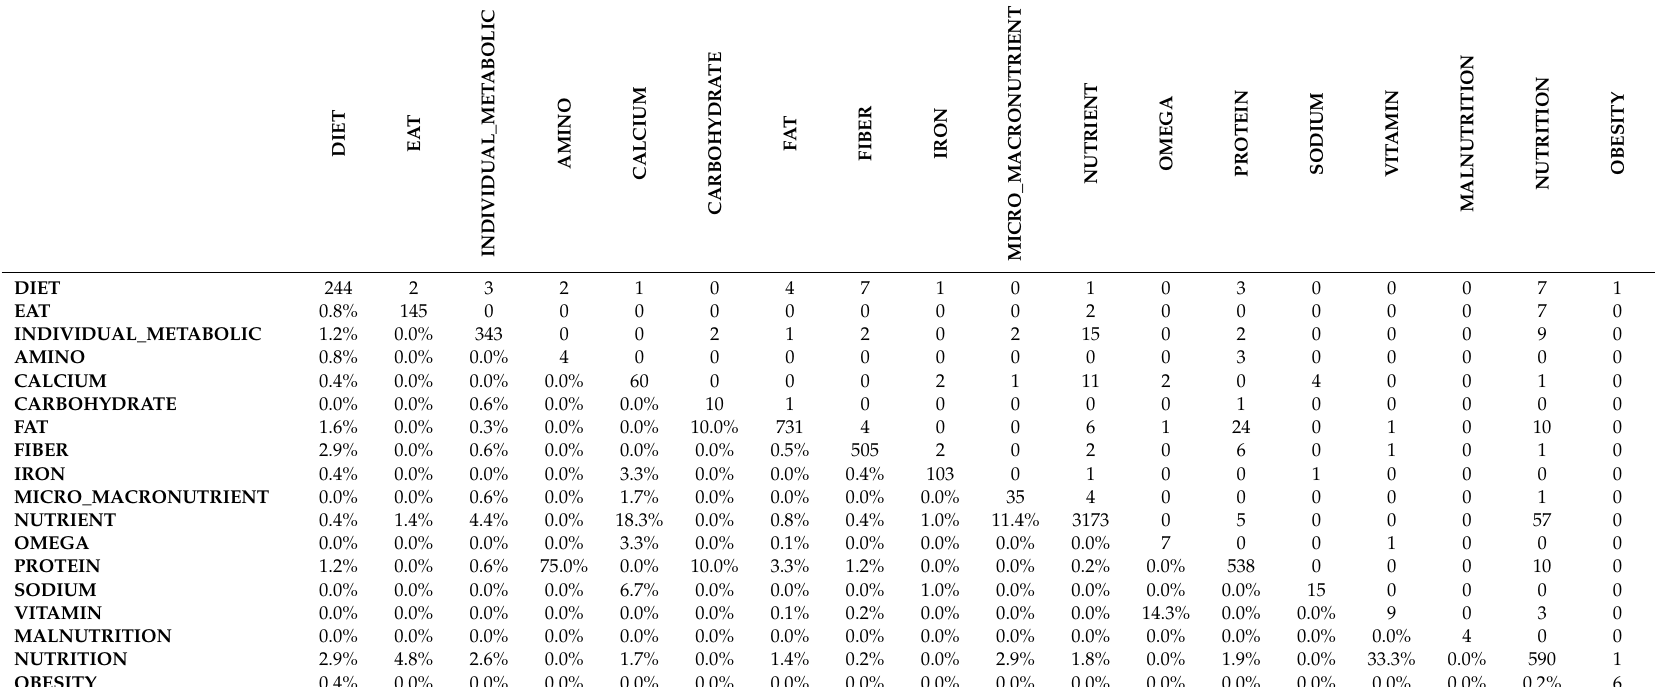
Table A9. Nutrition dimension categories